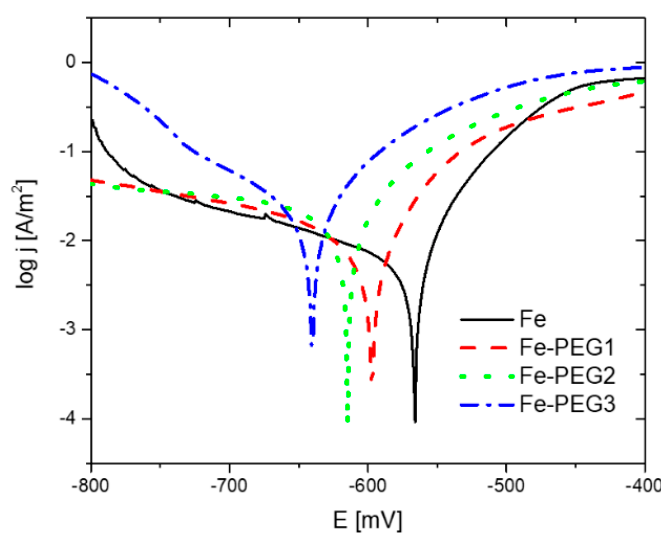
Figure 10. Potentiodynamic polarization curves of open cell iron samples with and without the PEG film obtained in Hanks’ solution at pH 7.4 and 37 °C at a scan rate 0.1 mV/s.